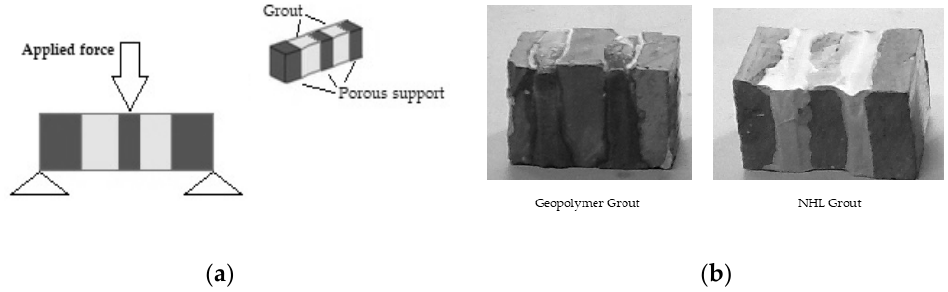
Figure 3. Adhesion test apparatus: ( a ) flexural tensile test scheme; ( b ) illustration of